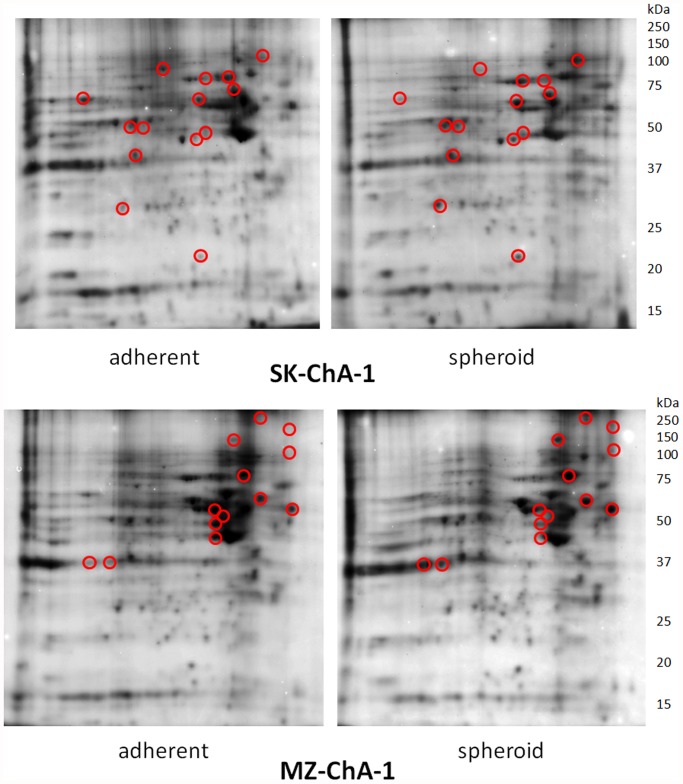
2D-PAGE separation of proteins contained in the cell lysates of SK-ChA-1 and MZ-ChA-1.Proteins were first separated by IEF (pH range 3–10) on a non-linear IEF strip (basic pH at the right) followed by SDS-PAGE in the vertical dimension on a 12.5% gel. Circled protein spots were analyzed by mass spectrometry to compare the relative abundance and results were reported in Table 1.